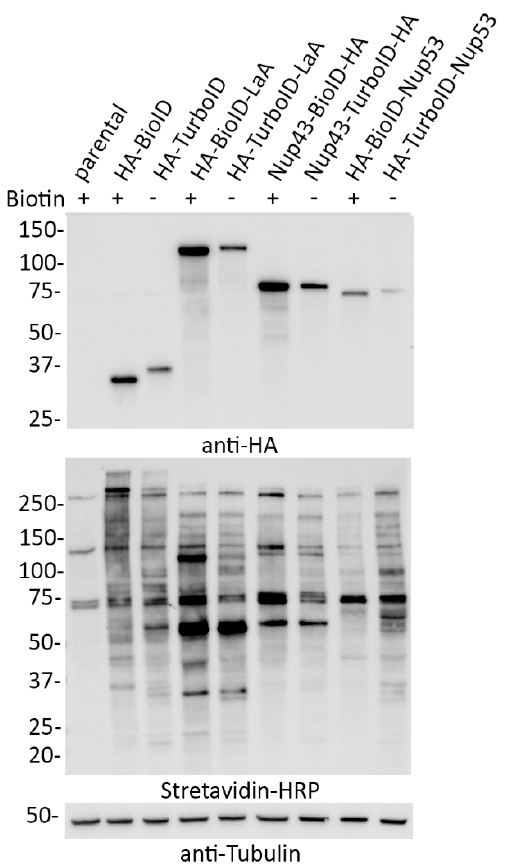
Figure 2. TurboID-fusion proteins biotinylate without the addition of biotin at similar levels to BioID- fusion proteins with biotin supplementation. Whole-cell lysates of A549 cells stably expressing BioID- or TurboID-tagged LaA, Nup43, or Nup53 fusion proteins were analyzed via western blot in the presence (+) of 50 μ M biotin supplementation for 18 h or absence ( − ) of biotin supplementation. Anti-HA was used to detect fusion protein levels and streptavidin-HRP was used to probe for biotinylation. Anti-tubulin was used as a protein loading control.